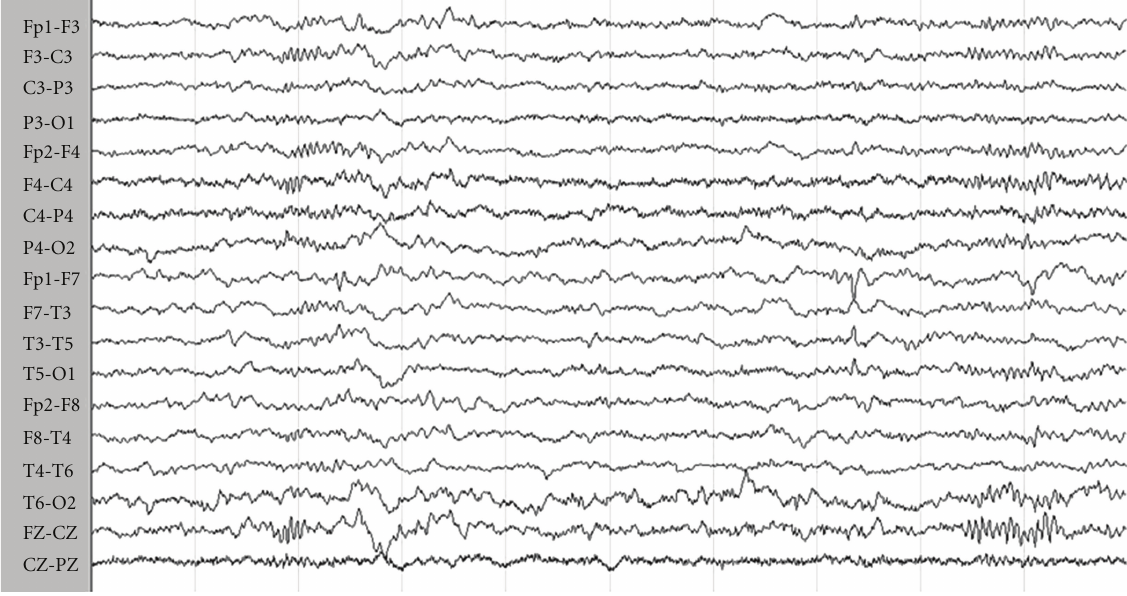
Figure 2: EEG activity after diazepam administration. After diazepam administration, the patient fell asleep, and EEG recording showed sharp waves on the left frontotemporal area during stage 2 NREM